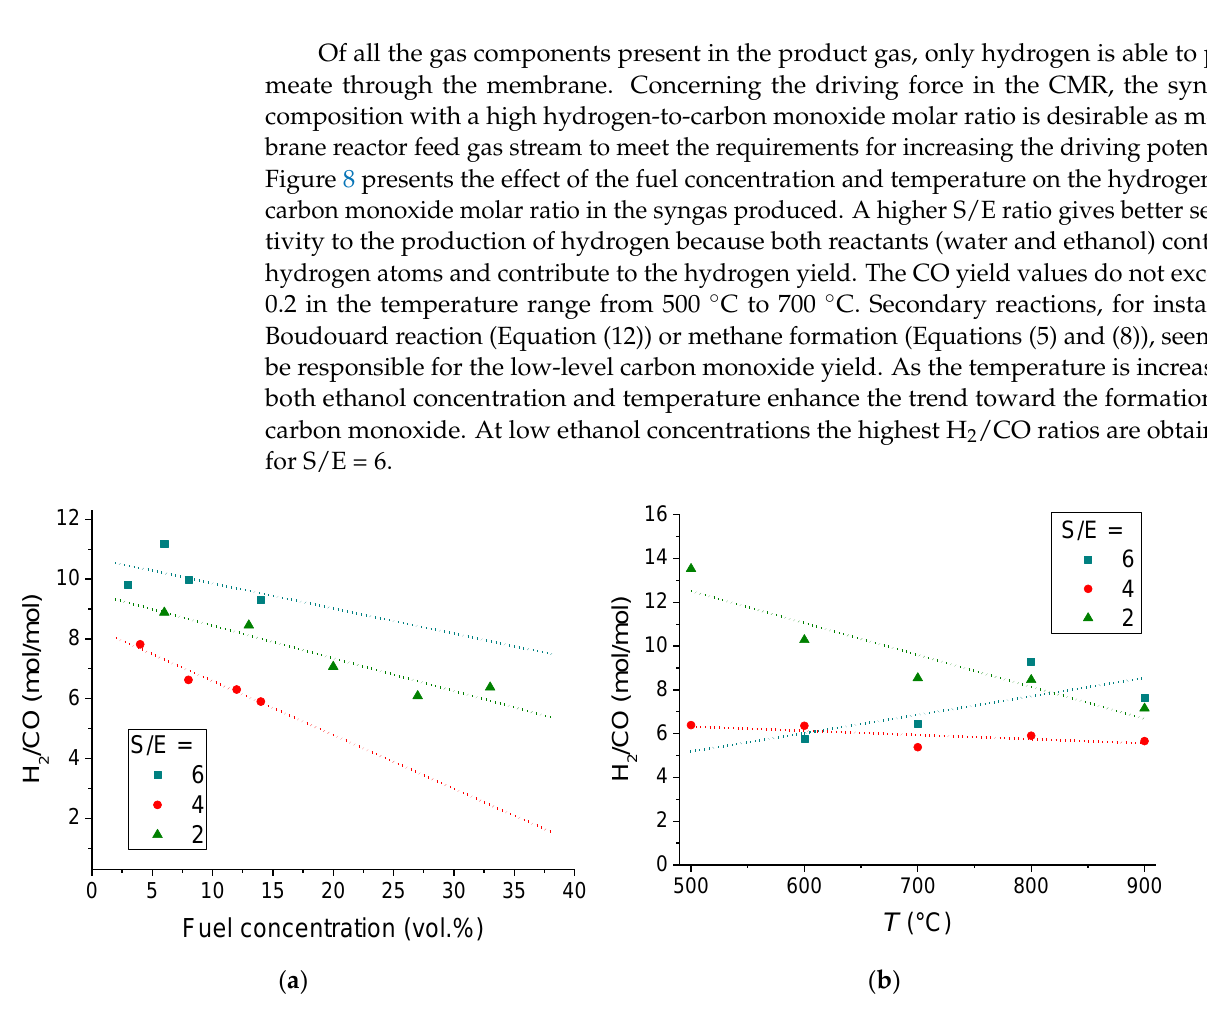
Figure 8. Hydrogen-to-carbon monoxide molar ratio in the syngas formed at the S/E = 6,4,2. ( a ) Effect of ethanol concentration at the operating temperature of 800 °C. ( b ) Effect of the temperature at the ethanol concentration in vol.%: of 14 (S/E = 6), 16 (S/E = 4), 13 (S/E = 2).